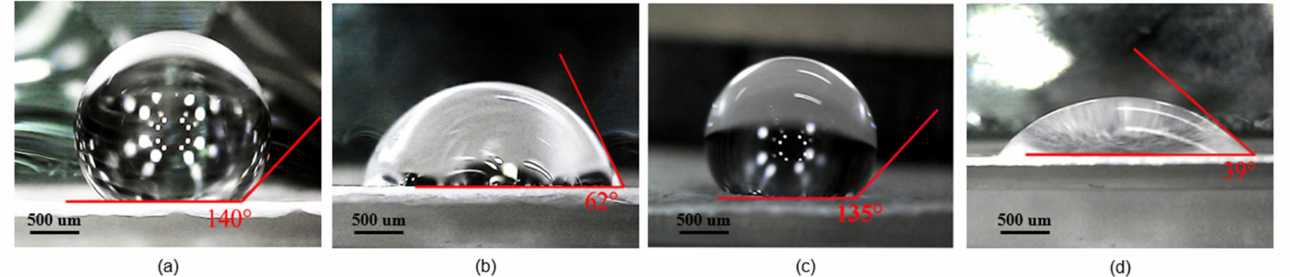
Figure 7. Water contact angle: ( a ) bare hydrophobic PTFE, ( b ) ethanol-treated hydrophobic PTFE (before heat treatment), ( c ) ethanol-treated hydrophobic PTFE (after heat treatment), ( d ) hydrophilic PTFE.